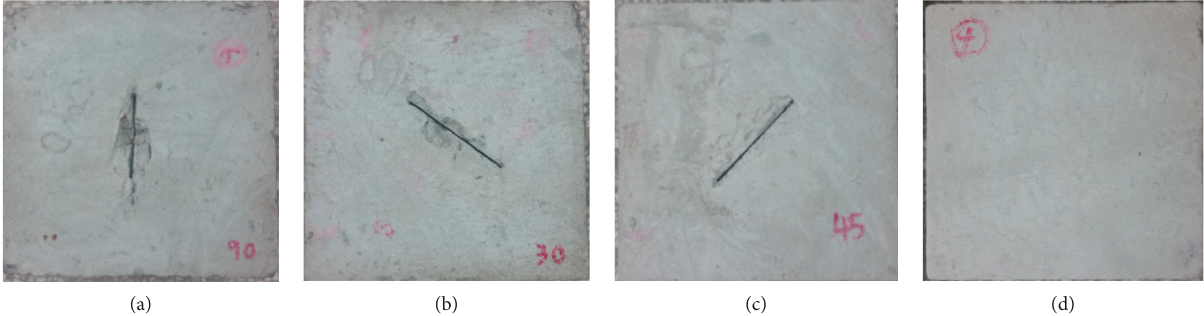
Figure 9: Cracked and intact samples. Crack: (a) 90 ° , (b) 30 ° , (c) 45 ° , and (d) intact sample.